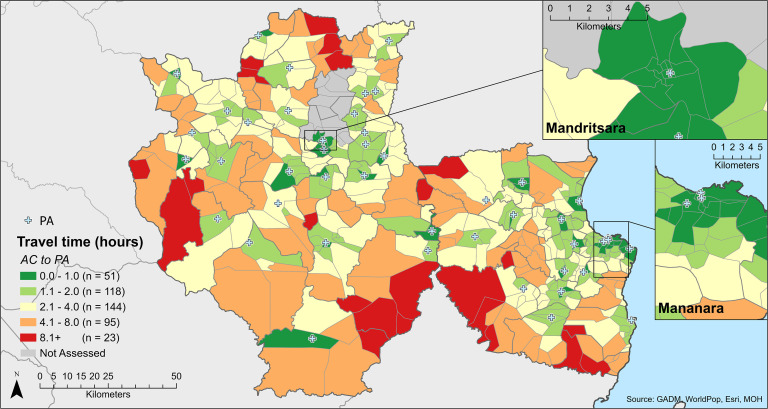
Estimated Travel Time for AC From Each Fokontany to Their Assigned PA by Foot During the Dry Season (1 Way)Abbreviations: ACs, agents communautaires (community health workers); PA, points d’approvisionnement (supply points).